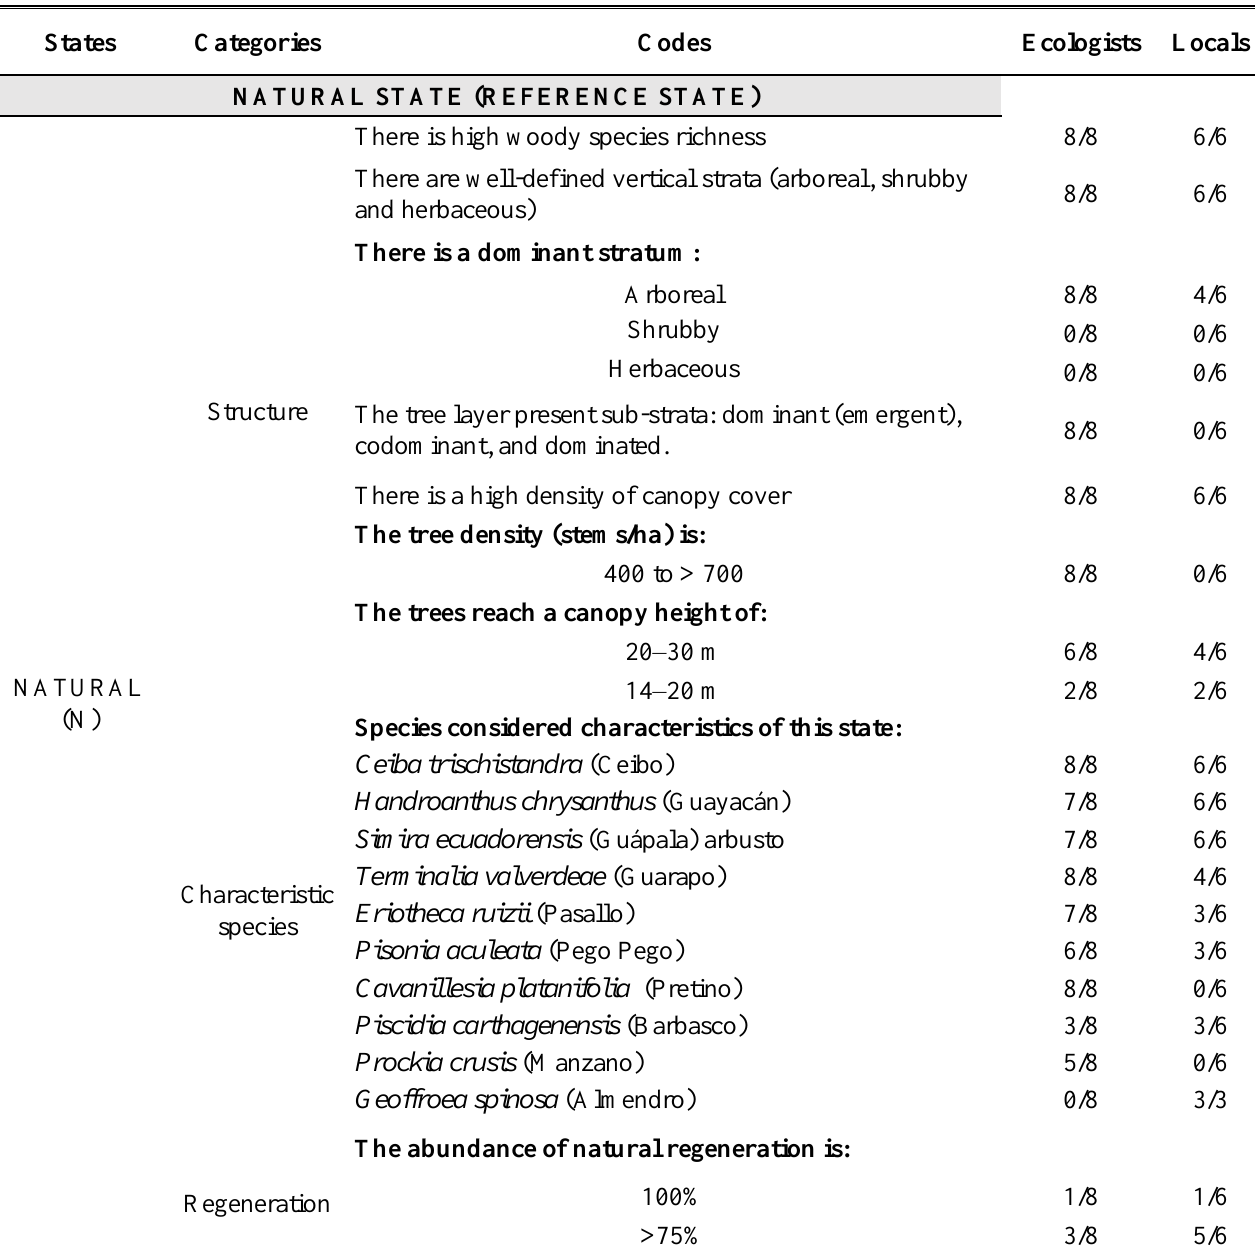
Table A3.1. Characteristics of the forest states, actions behind the transitions and actions necessary for the recovery of the forests, obtained from the responses of ecologists and locals during the first round of interviews. The values into the ecologists and locals show the frequency of agrees with respect to the total number of interviewees during the member